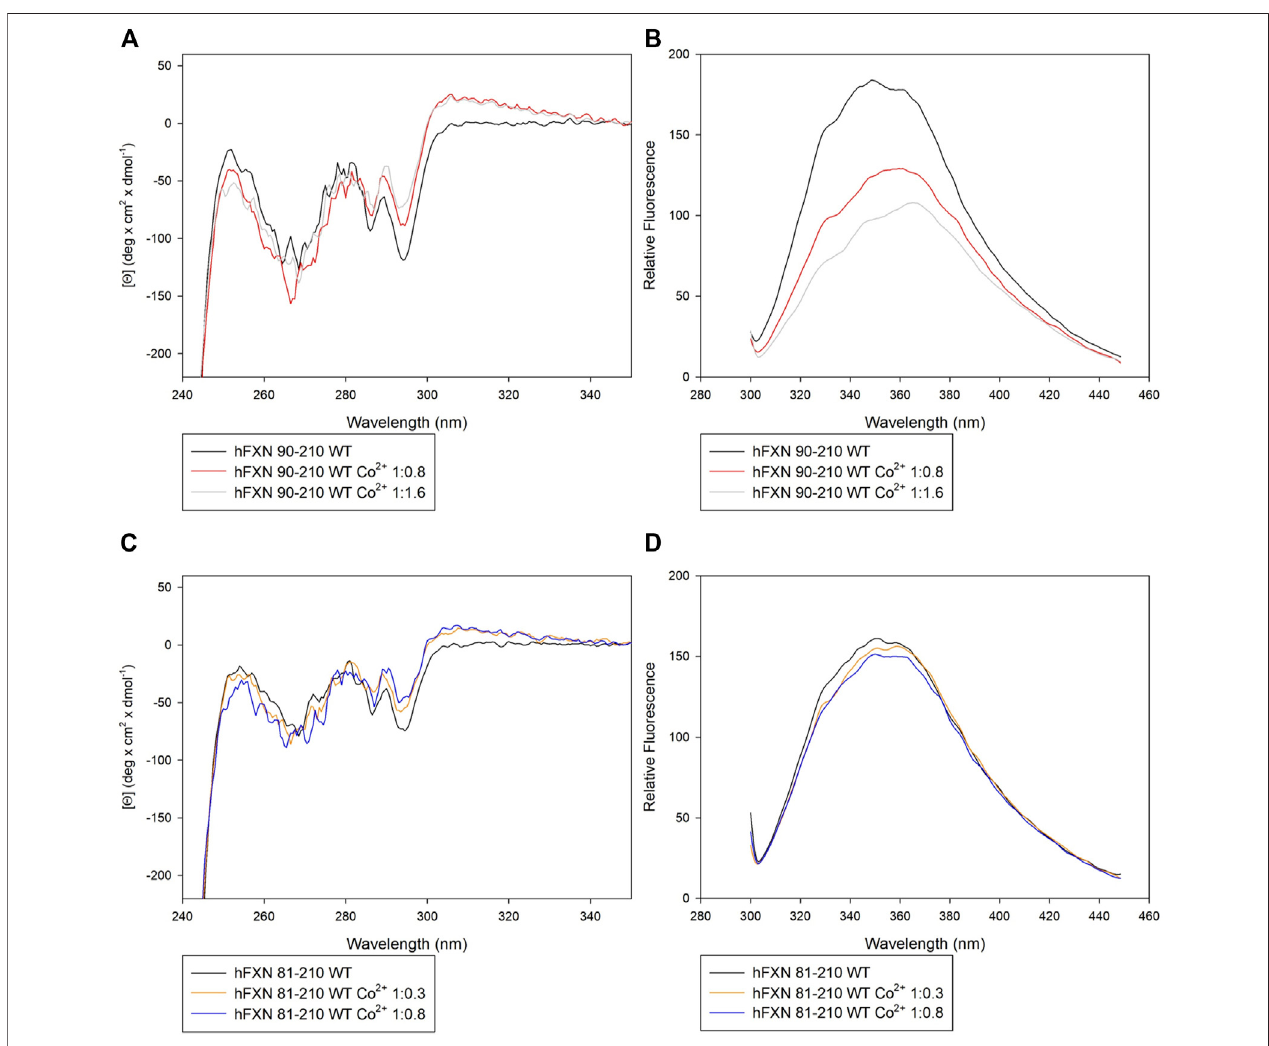
FIGURE 2 | Spectroscopic characterization of FXN isoforms with and without Co 2+ . (A) Near-UV CD spectra of FXN 90-210 in the absence of Co 2+ (black) and in the presence of 0.8 (red line) and 1.6 (grey line) Co 2+ equiv. (B) Intrinsic fl uorescence emission spectra of FXN 90-210 in the absence of Co 2+ and in the presence of 0.8 and 1.6Co 2+ equiv(code colorisasinpanel A ). (C) Near-UVCDspectraofFXN 81-210 intheabsenceofCo 2+ (dark purple) andinthepresenceof0.3(orange)and 0.8 (blue)Co 2+ equiv. (D) Intrinsic fl uorescence emission spectraofFXN 81-210 intheabsenceofCo 2+ and inthepresence of0.3 and0.8Co 2+